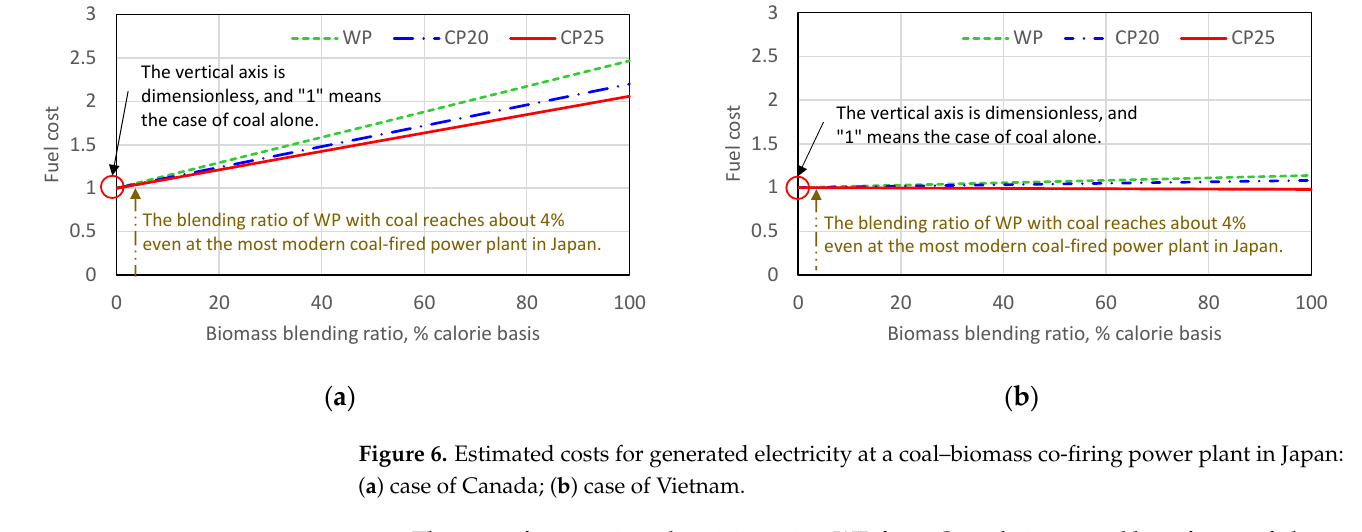
Figure 5. Estimated CO 2 emissions at a coal–biomass co-firing power plant in Japan: ( a ) case of Can- ada; ( b ) case of Vietnam.